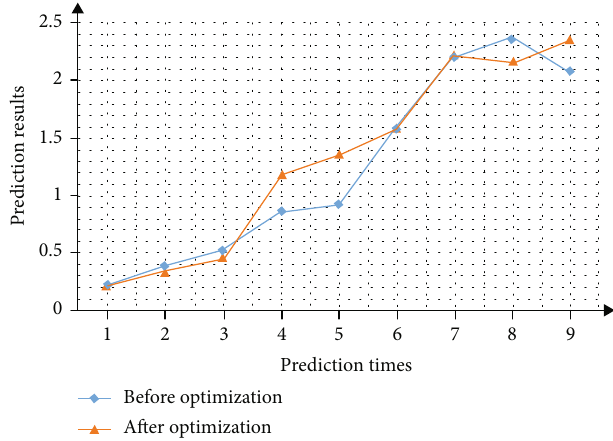
Figure 6: Prediction results of particle swarm optimization algorithm.